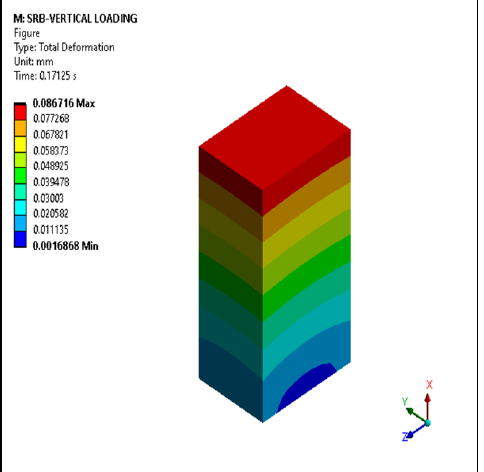
Figure 32. Stress ( left ) and strain ( right ) distribution of sustainable red mud bricks using ANSYS. 8. Stress and Strain Distribution The stress distribution of the SRMB acted on the midpoint of the brick. The Von mises stress is given in the Figure below. As the brick is brittle, the plastic strain distribution was gradually applied until failure. The stress–strain distribution for the horizontal and vertical load brick is graphically represented in Figure 33. The graph illustrates that the load was gradually applied and failed at the peak point, as shown in the chart. The material properties of the SRMB in both the horizontal and vertical axes are given in Table 15. Table 15. The material properties of the SRMB. Property